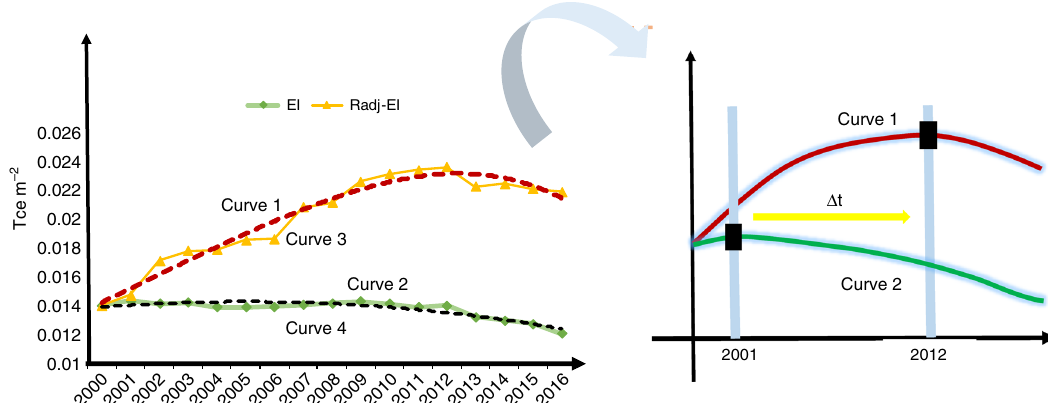
Fig. 4 Change trend and in fl ection point of the energy intensity. a URBEC per square meter from 2000 to 2016 in China. b The in fl ection point of the URBEC per square meter. Curve 1 refers to the trend line of the URBEC per square meter without considering the dilution effect. Curve 2 refers to the trend line of the URBEC per square meter considering the dilution effect. Curve 3 refers to the line chart of the energy intensity (URBEC per square meter) considering the dilution effect. Curve 4 refers to the line chart of the energy intensity (URBEC per square meter) without considering the dilution effect. Δ t is the delayed time between the in fl ection points of curve 1 and curve 2. EI represents the URBEC per square meter without considering the dilution effect and Radj-EI represents the URBEC per square meter with considering the dilution